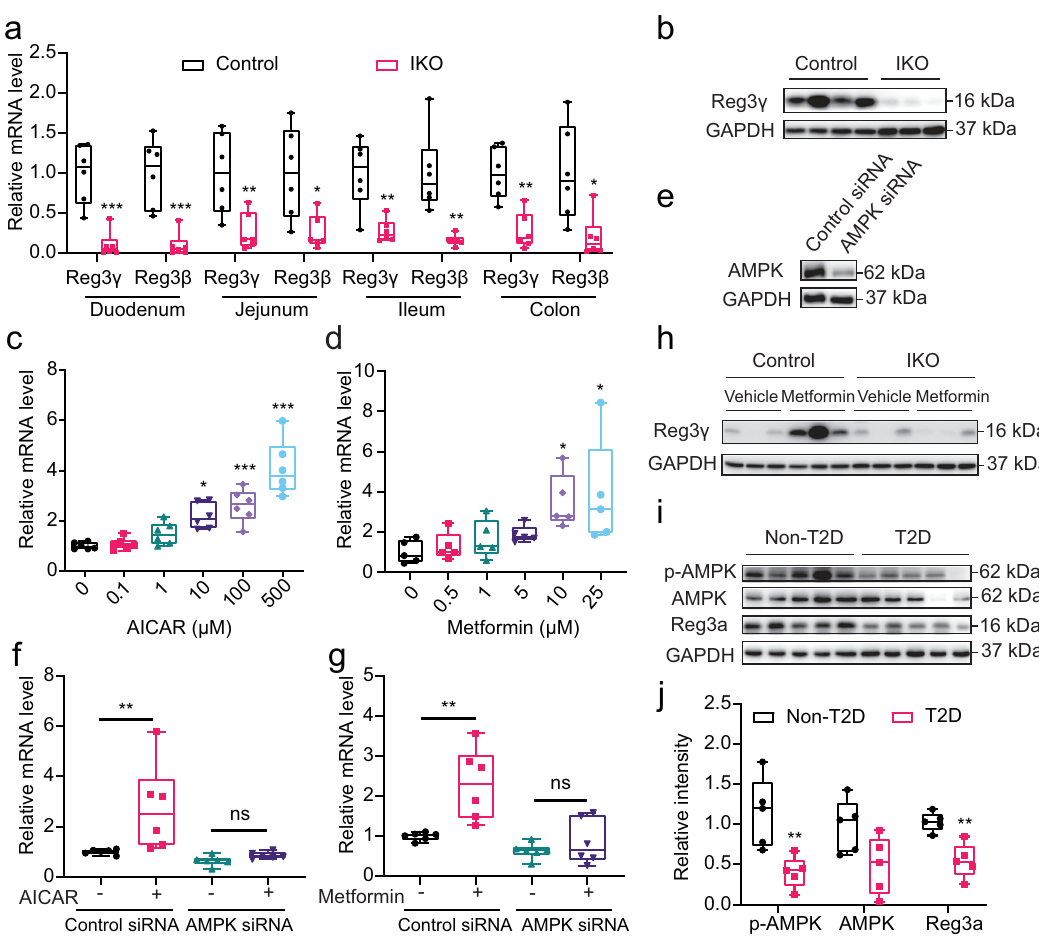
Fig. 3 Intestinal AMPK α 1 regulates the AMP Reg3. a Relative mRNA levels of Reg3 γ and Reg3 β in the duodenum, jejunum, ileum, and colon of AMPK α 1 fl / fl (Control) and AMPK α 1-IKO mice fed chow diet ( n = 6 biologically independent samples). P value: 0.0003, 0.0007, 0.0095, 0.0143, 0.0029, 0.0022, 0.0011, 0.0143. b Representative Reg3 γ protein levels in the jejunum of mice fed chow diet. c , d Relative mRNA levels of Reg3 α in HT-29 cells treated with gradient concentrations of AICAR ( c , n = 6 biologically independent samples, P value: 0.0078, 0.0004, <0.0001) and metformin ( d , n = 5 biologically